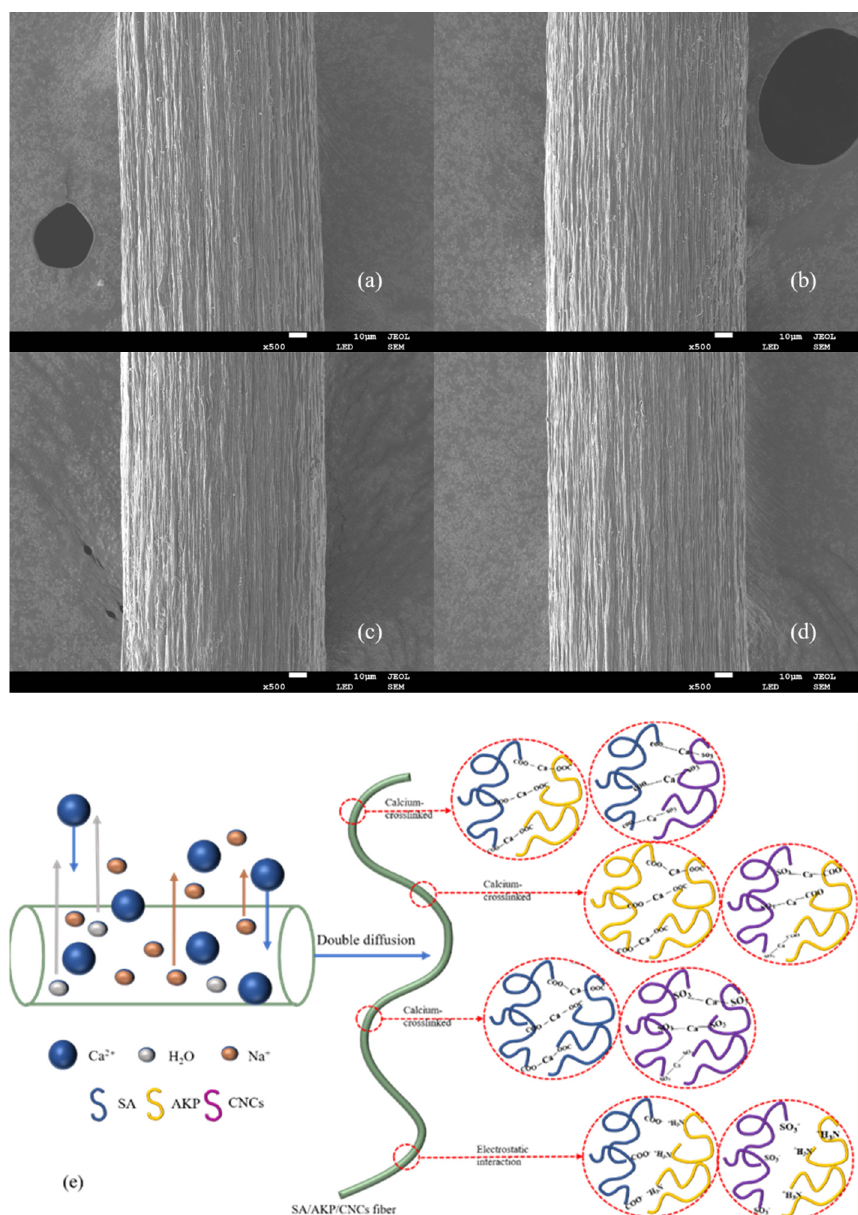
Figure 9. The surface morphology of SA/AKP/CNCs composite fiber, ( a ) SAC-0.8-45, ( b ) SAC-0.8- 55, ( c ) SAC-1.2-45, ( d ) SAC-1.2-55, ( e ) double diffusion and ionic crosslinking of SA/AKP/CNCs composite fiber.